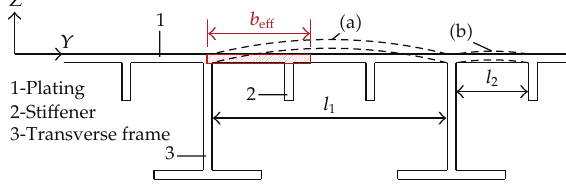
Figure 20: Calculation of the e ff ective width.